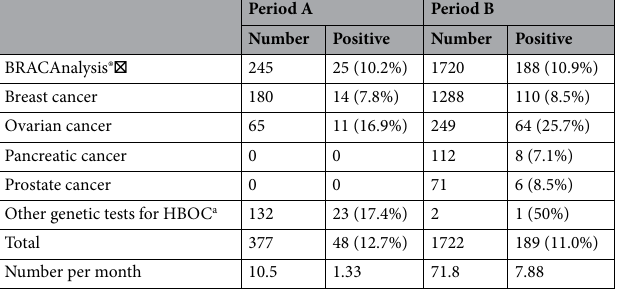
Table 3. Genetic testing performed in each group. a Hereditary breast and ovarian